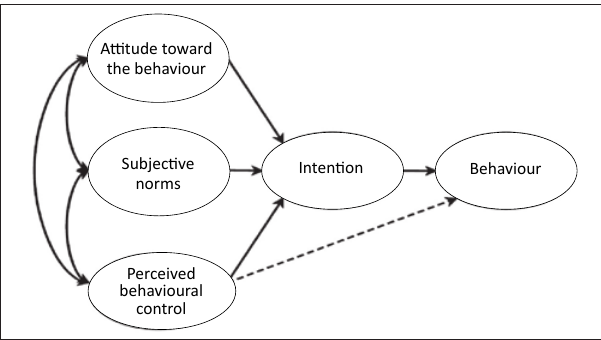
FIGURE 1: Theory of Planned Behaviour.